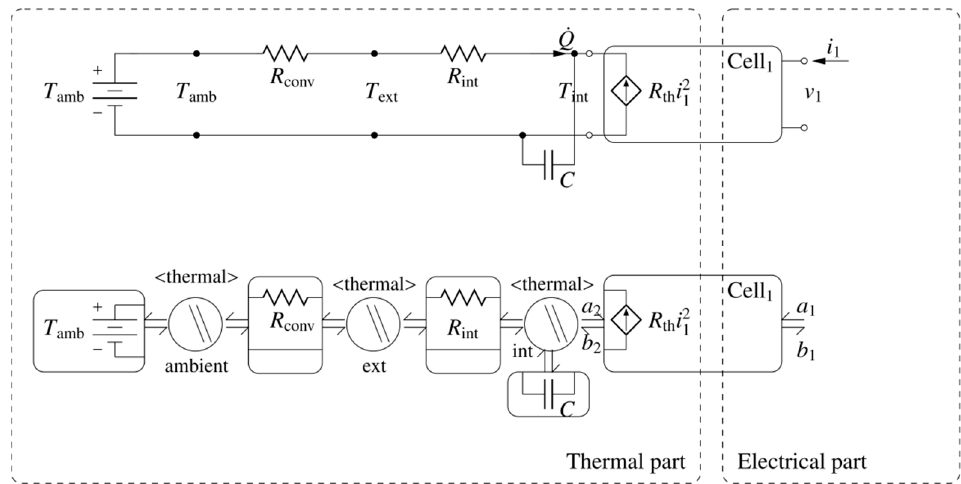
Figure 3. Thermal schematic of a single cell ( top ) and its SystemC-WMS implementation ( bottom ).